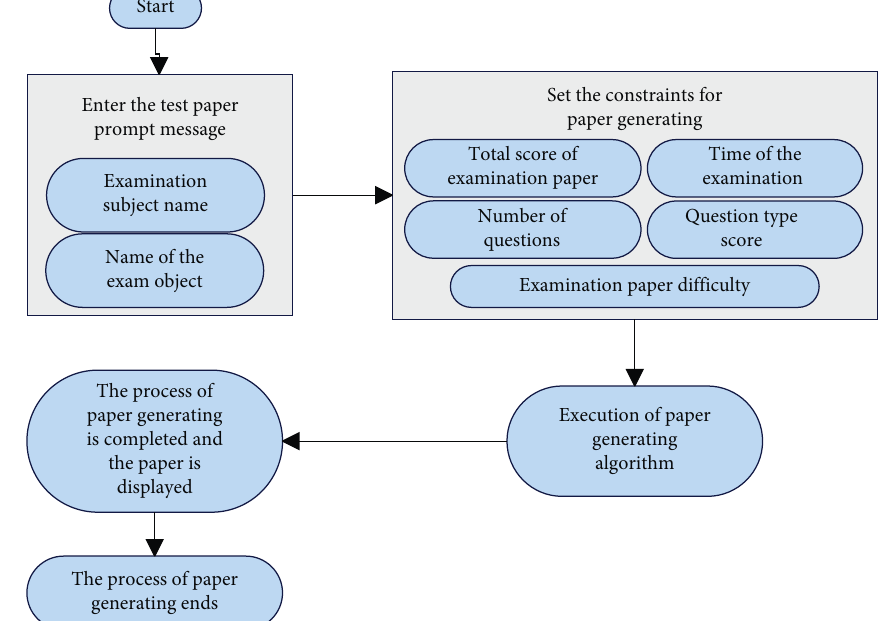
Figure 1: Flow analysis diagram of the test paper composition system.